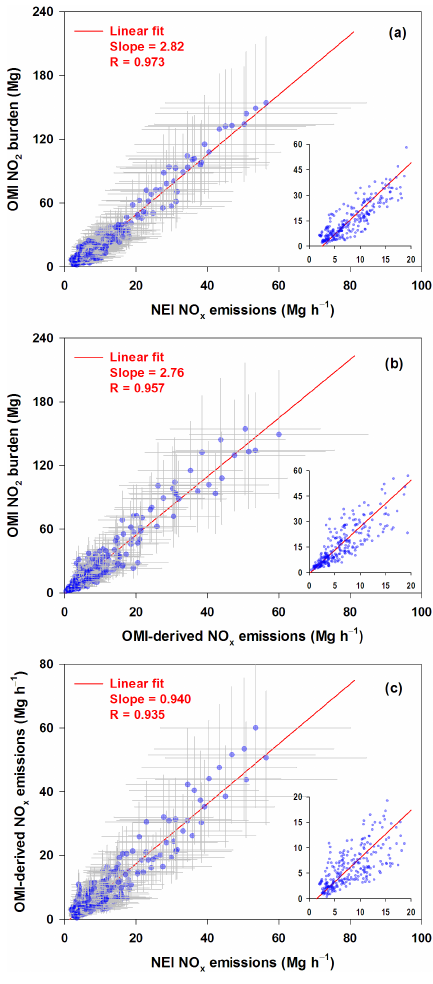
Figure 6. Scatter plots of (a) OMI-observed NO 2 burdens at low- wind-speed (<3ms − 1 ) condition against NEI NO x emissions, (b) OMI-observed NO 2 burdens against OMI-derived NO x emis- sions, and (c) OMI-derived NO x emissions against NEI NO x emis- sions for 35 selected US urban areas during 2005–2014. Each point represents a 3-year result for an urban area. Error bars express the ± 1 SD uncertainties. Uncertainties of NEI emissions are set to be 50% according to the expert judgment. The inset figures are the enlarged views of points with emissions <20Mgh − 1 .